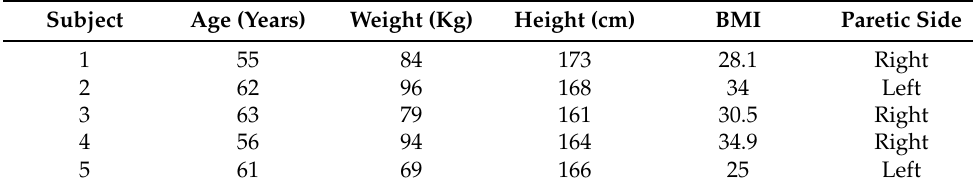
Table 1. Subjects’ clinical